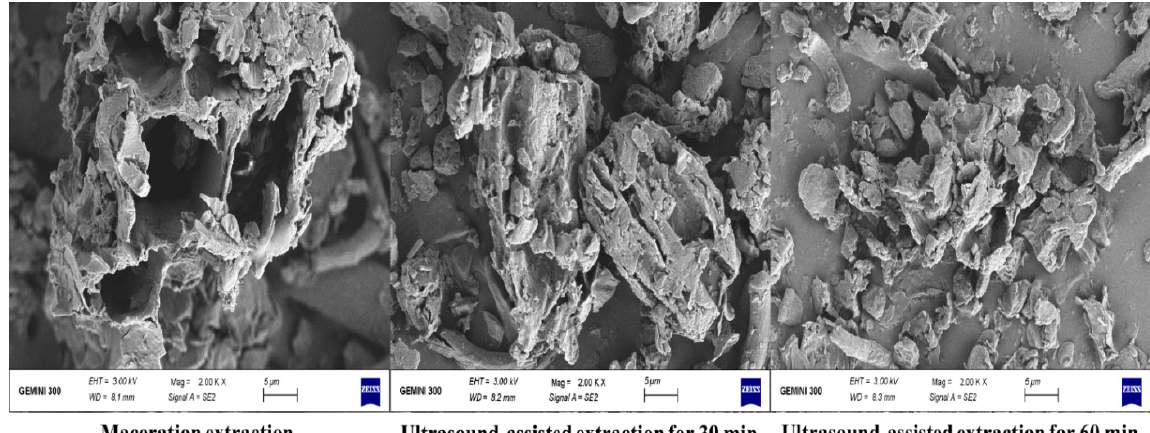
Figure 6. Scanning electron micrographs of ultrasound-assisted extraction (UAE) and Maceration extraction (ME) meth- ods.